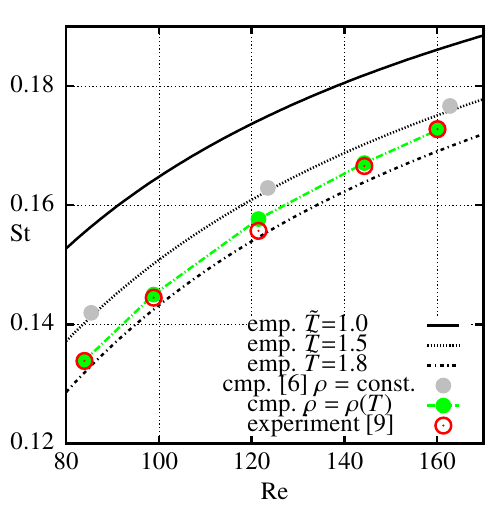
Fig. 3. Direct comparison of data from model proposed in [6] with current data (same setting of discretisation) and empirical formulas [10]. All computations "cmp." and experimental "exp." data belong to temperature ratio ˜ T = T +